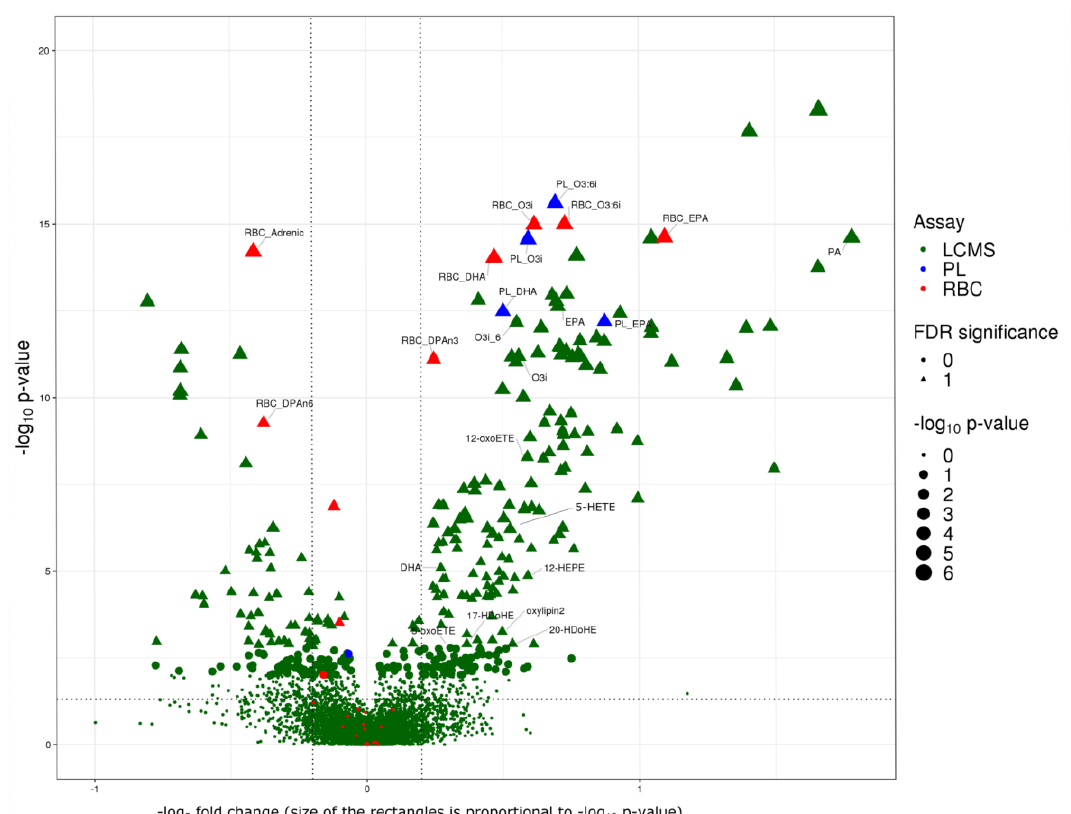
Figure 4. Volcano plot of fold changes from baseline to year one of FAs, oxylipins and small bioactive lipid features in response to randomized n-3 treatment in VITAL200. Seven bioactive lipid features with − log 2 (fold change) > 2.0 and − log 10 ( p -value) > 18 are not displayed. Fold changes were calculated median n − 3 treatment / median placebo . Horizontal dashed line corresponds to p -value of 0.05, vertical dashed lines correspond to 20% change. False Discovery Rate (FDR) significance: significant controlling for False Discovery Rate at 0.05. P -values were estimated by Wilcoxon test. Assays: LCMS—high-throughput liquid chromatography–mass spectrometry of nontargeted circulating free FAs, oxylipins and bioactive lipids in plasma; RBC—gas chromatography with flame ionization detection for red blood cells; PL—LCMS2 plasma phospholipids.